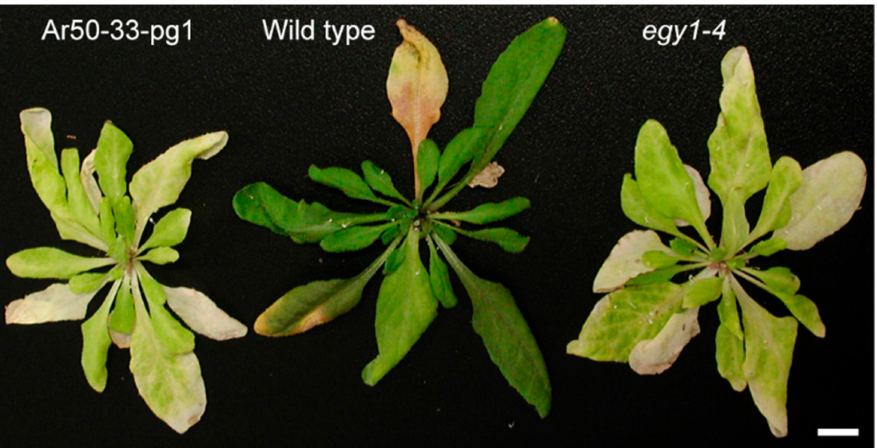
Figure 2. Rosette morphology of 6-week-old wild type and mutant plants. Stems were removed just prior to image capture. Bar = 1